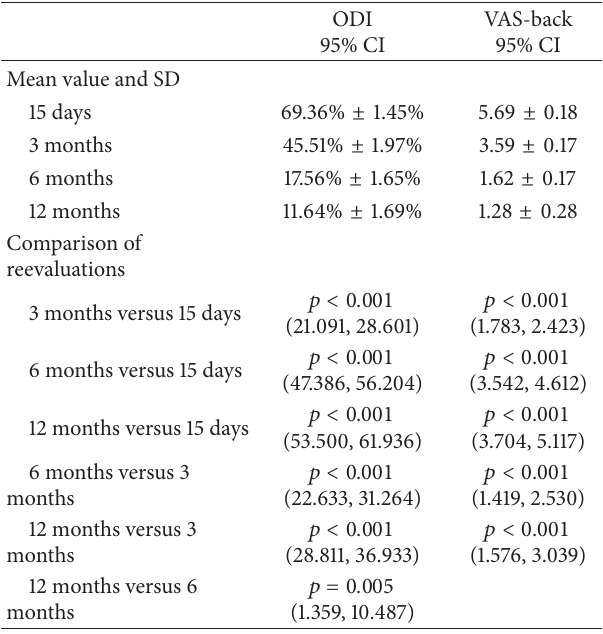
Table 4: Statistically significant improvements from the evaluation of the questionnaires ODI and